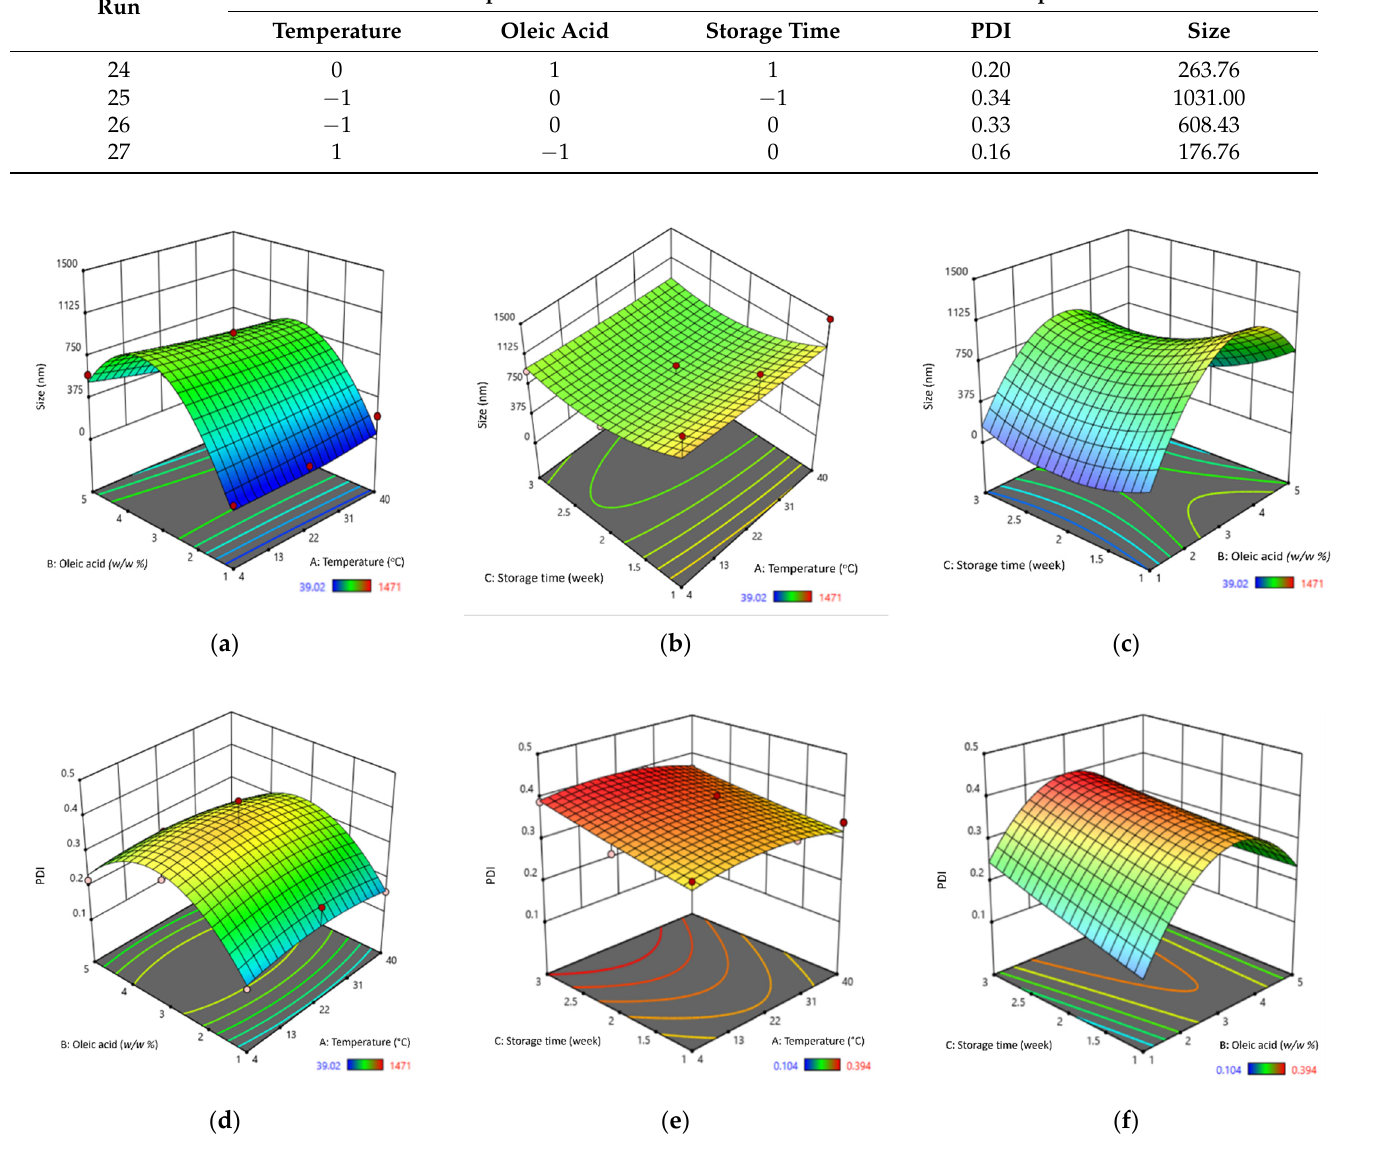
Figure 2. Response surface plot of the particle size of SBH NEs in response to the combined effect of temperature and oleic acid ( a ), temperature and storage time ( b ), and storage time and oleic acid ( c ); Response surface plot of the PDI of SBH NEs due to the combined effect of temperature and oleic acid ( d ), temperature and storage time ( e ), and storage time and oleic acid ( f ). A red dot represents points above the predicted value and a pink dot represents points below the predicted value.